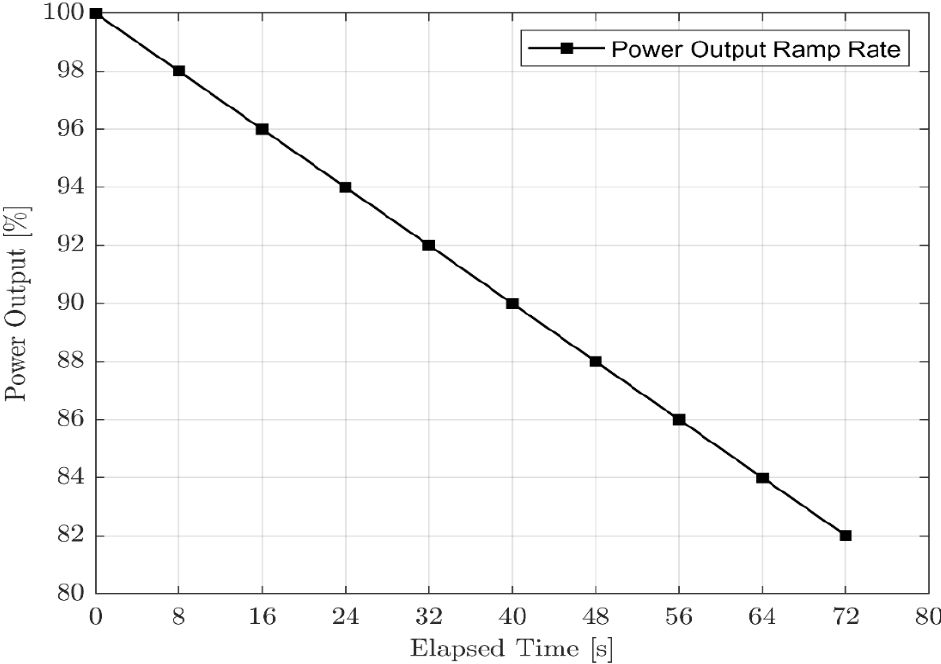
Figure 7. Power ramp down schedule in transient simulation.